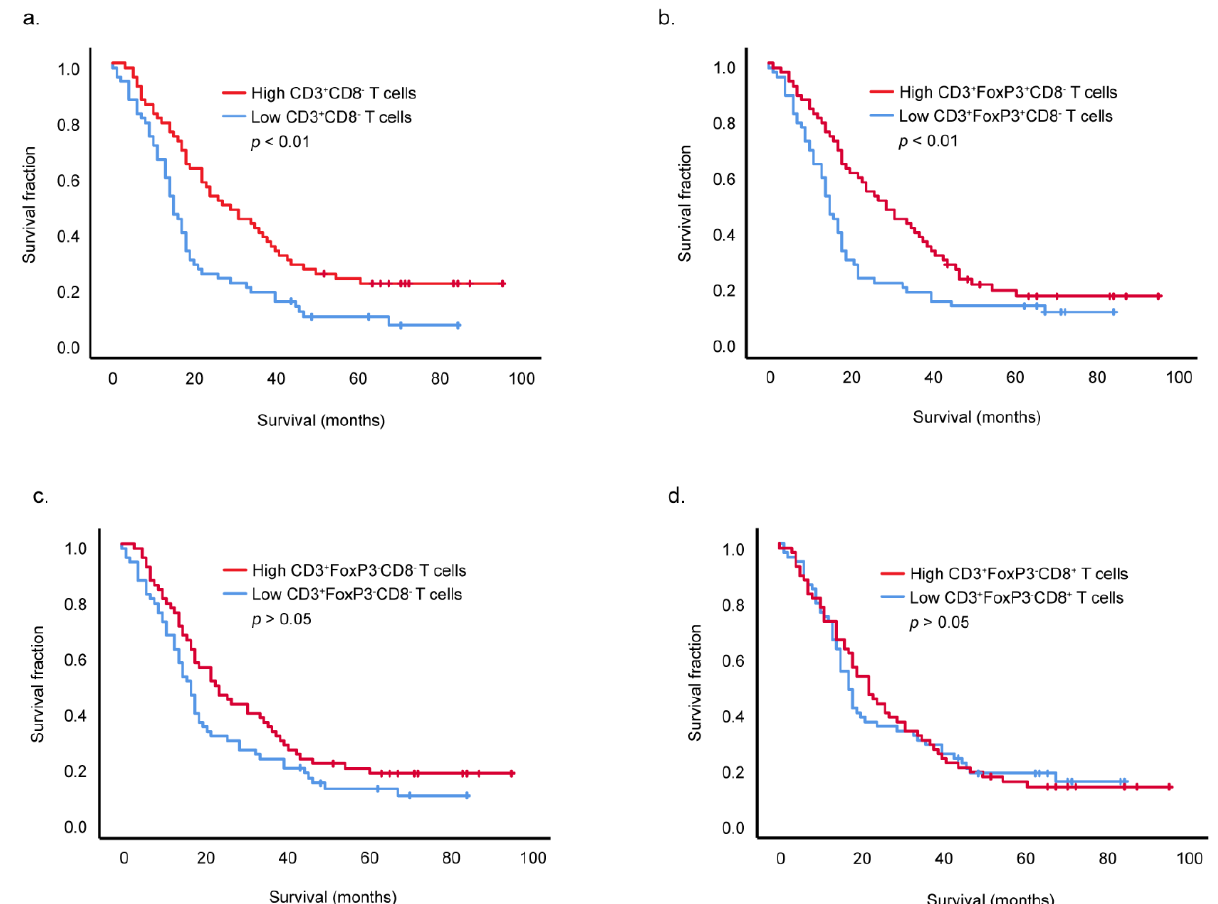
Figure 2. CD3 + CD8 − (CD4 + ) T cells (including Tregs) and Treg infiltration positively associate with improved overall survival of PDAC patients. Survival analyses of all 122 PDAC patients based on high and low infiltration by CD3 + CD8 − (CD4 + ) T cells (including Tregs) ( a ), CD3 + CD8 − FOXP3 + Tregs ( b ), CD3 + CD8 − FOXP3 − cells (CD4 + T helper cells) ( c ), cytotoxic CD3 + CD8 + T cells ( d ). High and low